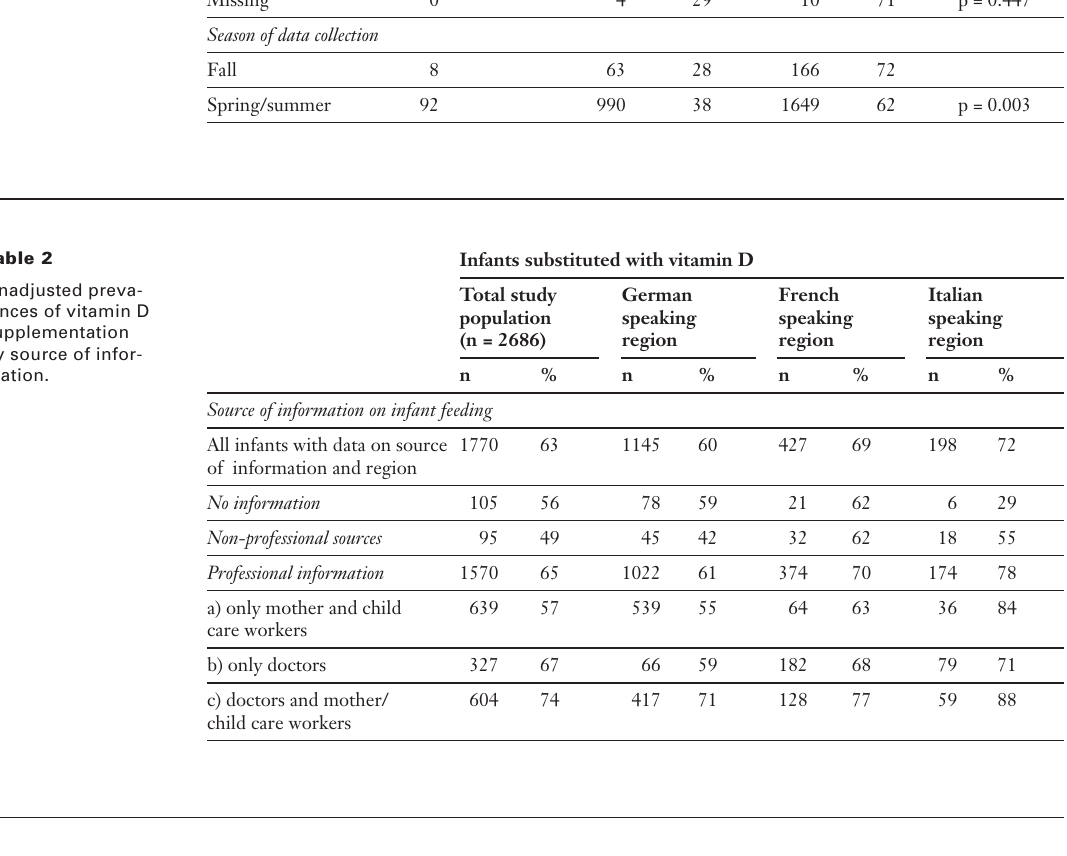
Table 3 Factors influencing vitamin D supple- mentation – results of multivariate regression. 1